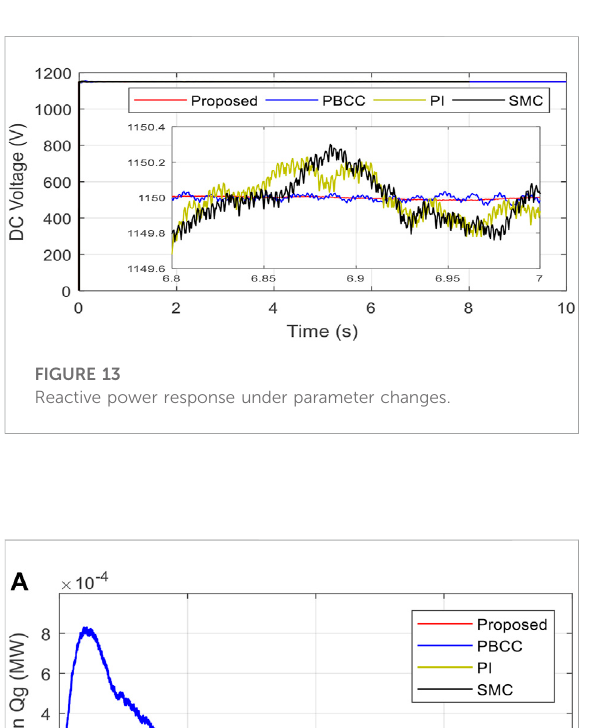
Figure 12 indicates the resemblance monitoring reaction of Q g